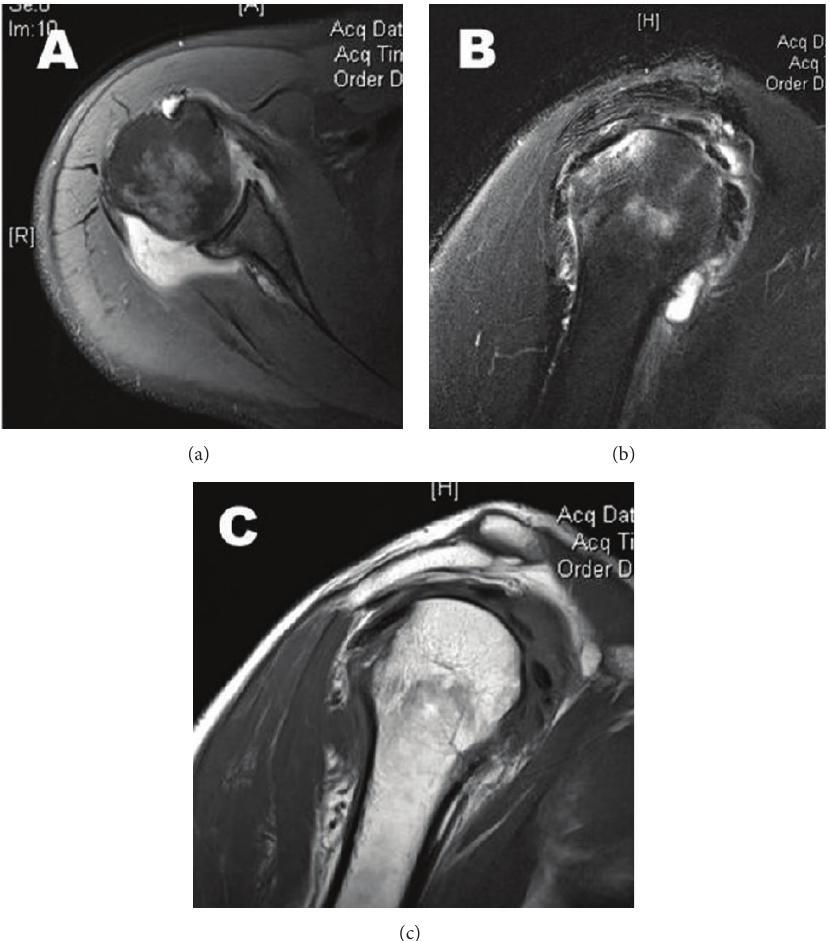
Figure 2: MRI of the right shoulder. (a) Axial proton density fat suppressed weighted image showing regions of low signal intensity within the joint effusion. (b) Sagittal proton density fat suppressed weighted image showing suppression of the signal intensity of the lesions, similar to subcutaneous fat. Bone erosion is present at the superior aspect of humeral head representing a Hill-Sachs fracture. (c) Sagittal T1-weighted image showing a large joint effusion and heterogeneous signal intensity within the periphery of the joint, suggestive of synovial